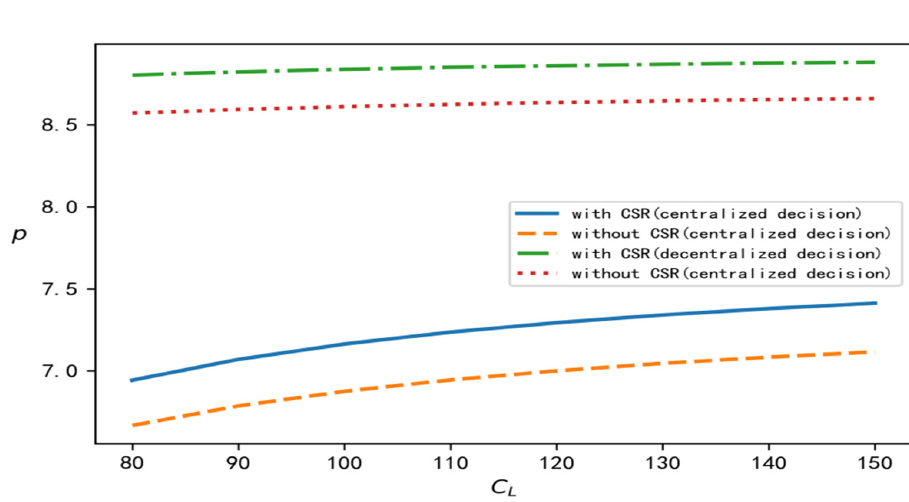
Figure 2. Change trend of product price.